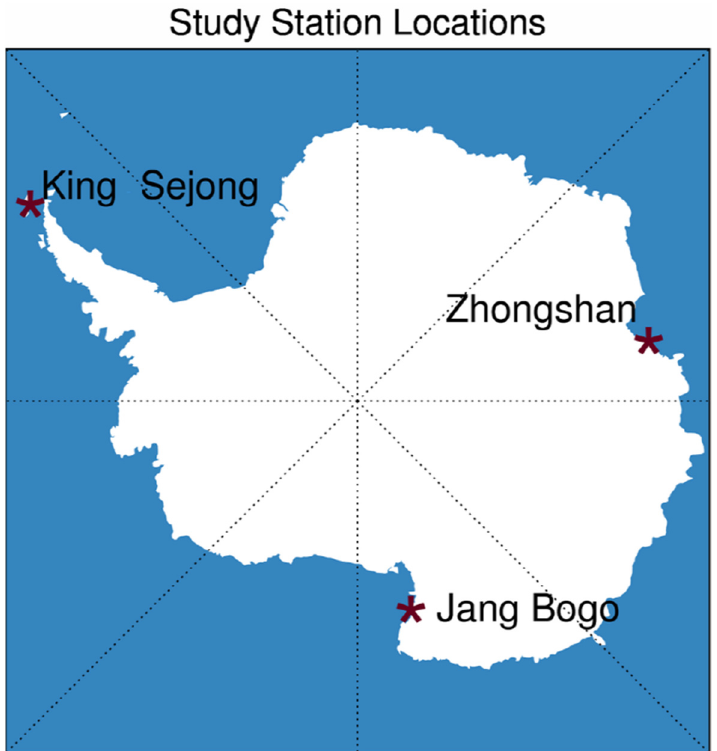
Table 1. Summary of Brewer specifications for each station used in this study.